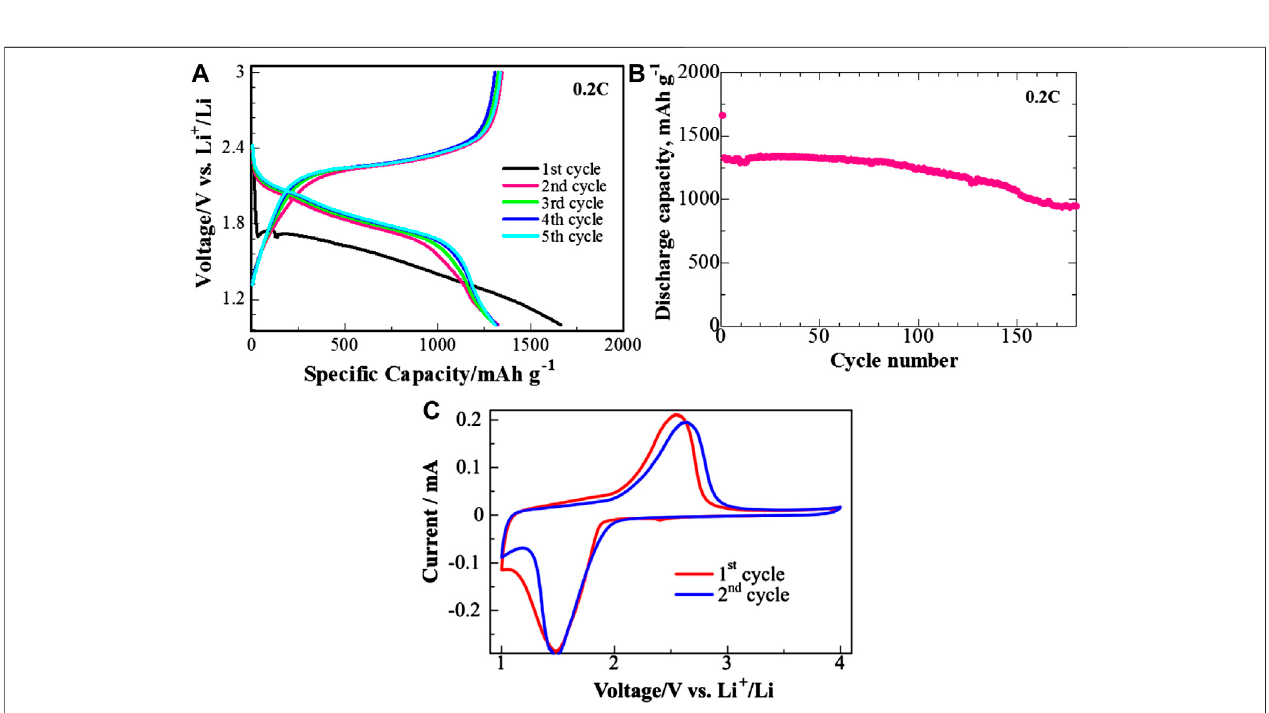
FIGURE 3 | (A) Charge/discharge pro fi les, (B) cyclability, and (C) cyclic voltammetry of the half-cell with S/PAN/KB cathode at 0.2 C. Coin type cells.